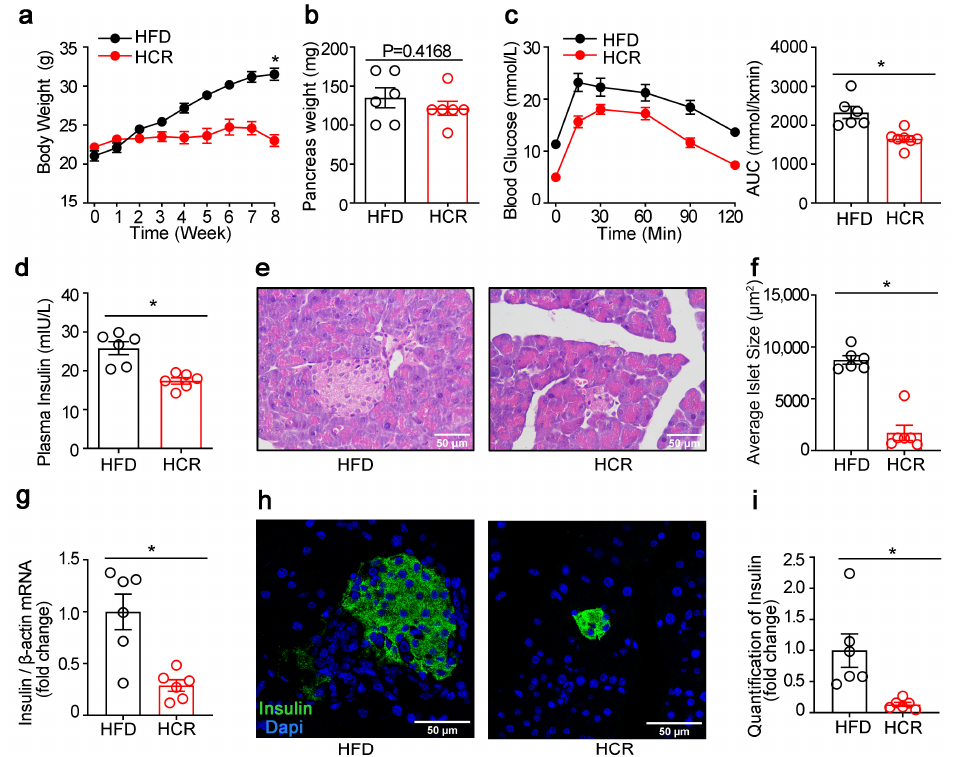
Figure 4. CR decreased insulin production in diabetic mice. ( a ) Body weight curves of CR-treated high-fat diet-fed mice. ( b ) Weight of pancreas. ( c ) Intraperitoneal glucose tolerance test. ( d ) Plasma insulin at 15 min after glucose injection. ( e ) HE staining of pancreatic sections. ( f ) Quantification of islet size. ( g ) Insulin mRNA. ( h ) Immunofluorescence staining for insulin (green) in the pancreas of mice fed with HFD or HCR. ( i ) Quantification of insulin. The results were expressed as mean values ± SEM. (six mice per group), * p < 0.05 vs. HFD mice.